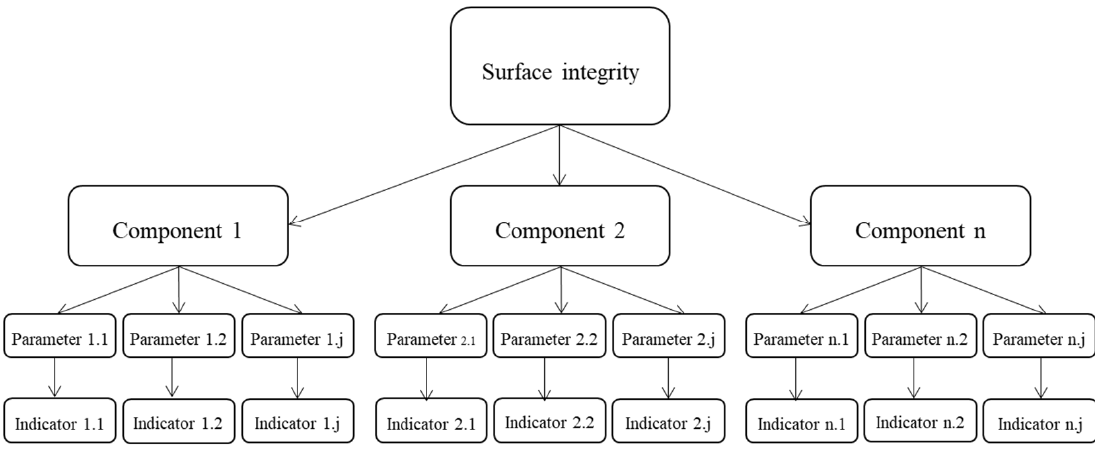
Figure 1. Structural organizational of surface integrity.